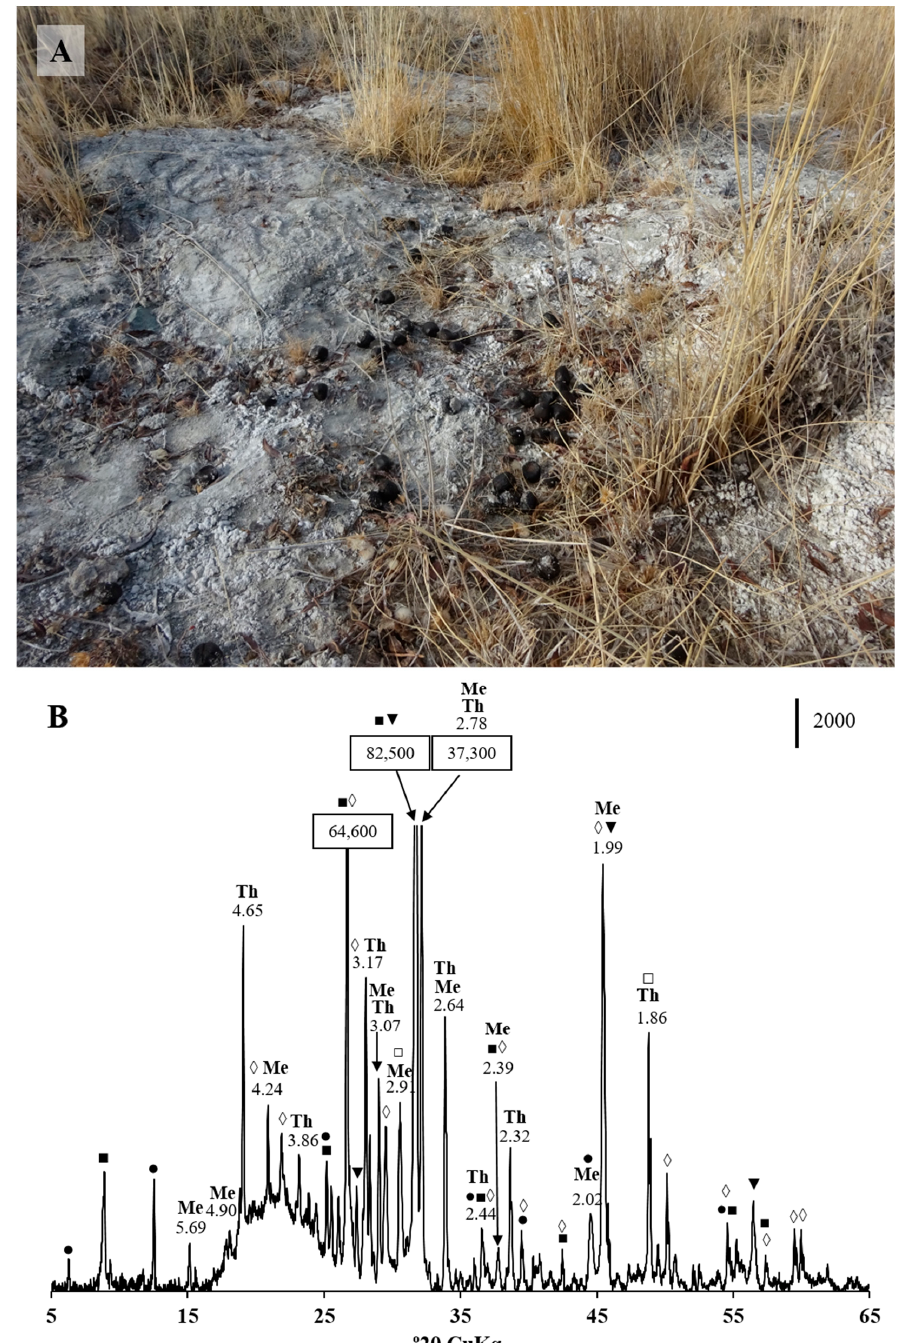
Figure 2. ( A ) Saline soil with camel feces, sampled for XRD analysis, and ( B ) X-ray diffraction pattern of the soil sample. Letter codes: Th = thenardite, Na 2 SO 4 ; Me = melanterite, Fe +2 SO 4 · 7H 2 O. The diagnostic peaks for muscovite ( ■ ), clinochlore ( ● ), calcite ( □ ), quartz ( ◊ ), and halite ( ▼ ) are indicated. The vertical bar shows the scale of relative counts.